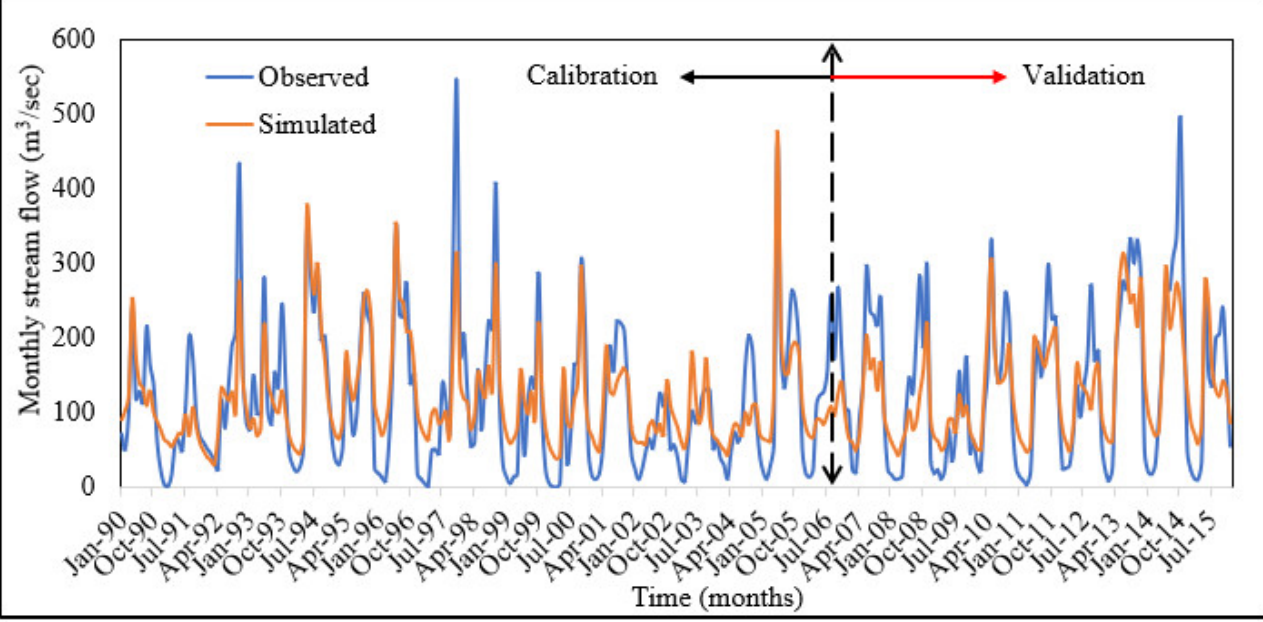
Figure 5. Monthly streamflow calibration and validation (1990–2015).